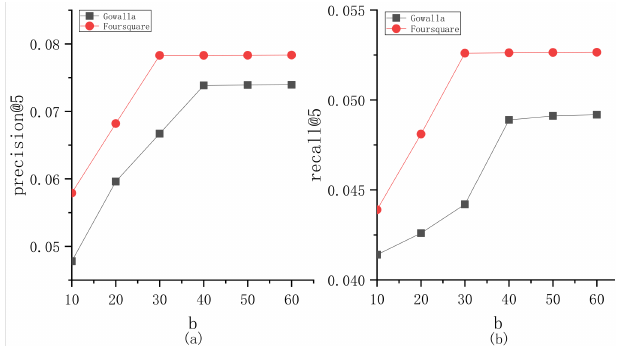
Figure 4. The sensitivity analysis of b . ( a ) precision @5; ( b ) recall @5.